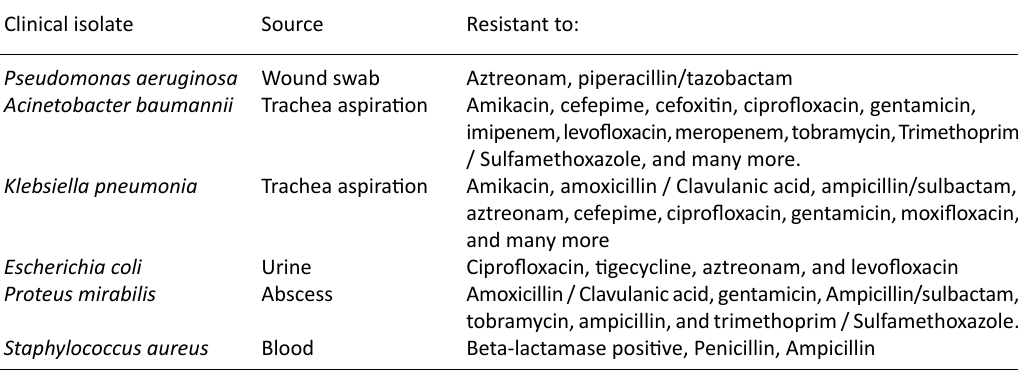
Table 2. The antibiotics susceptibility profile of the clinical bacterial strains Clinical isolate